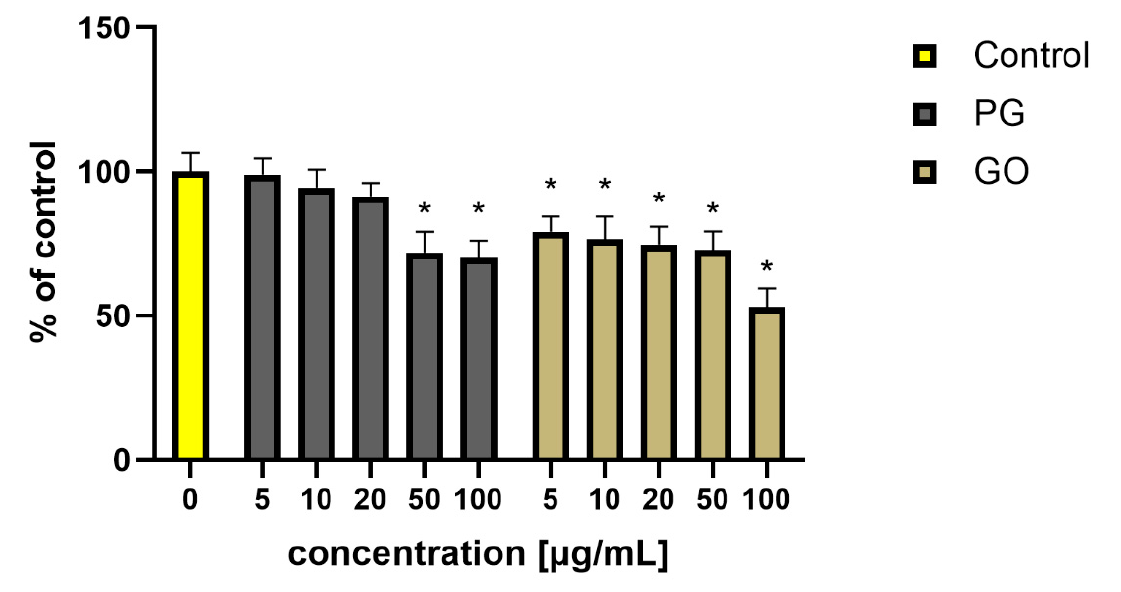
Figure 9. Viability of S. aureus (percent of the control) after PG and GO treatment. Values in the rows marked with an asterisk show statistically significant differences ( p < 0.05) as compared to the control assay. Abbreviations: C—control group (untreated cells); PG—pristine graphene; GO—graphene oxide.